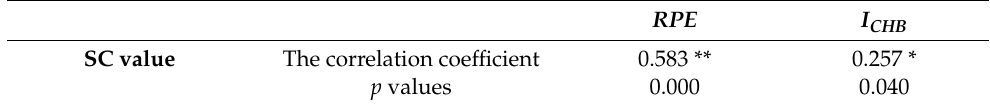
Table 4. Correlation statistics of SC, RPE and I CHB . RPE I CHB SC value The correlation coefficient 0.583 ** 0.257 * p values 0.000 0.040